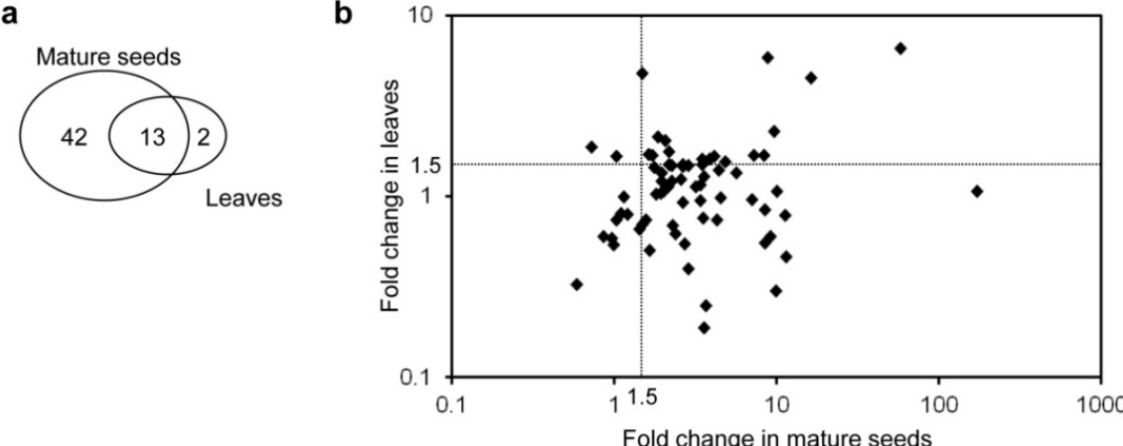
Figure 3. Changes in primary and secondary metabolite levels in mature seeds and